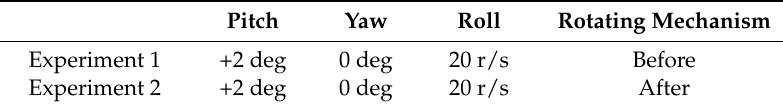
Table 9. Setting of the experiment conditions.